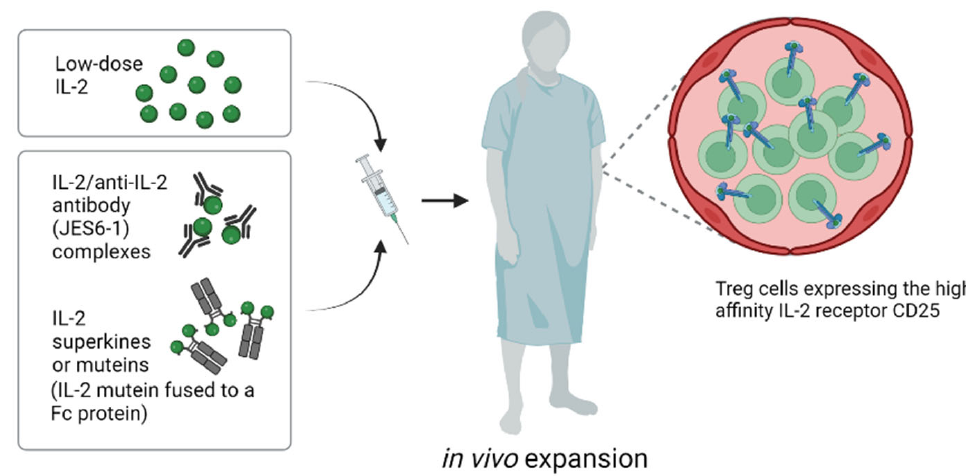
Figure 3. Approaches for in vivo expansion of Tregs (created with biorender.com).